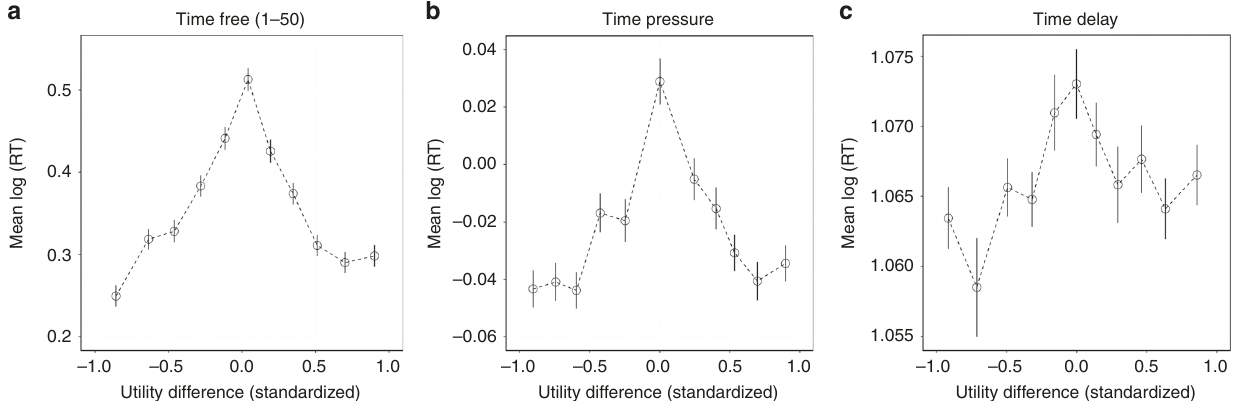
Fig. 3 The relationship between log(RT) and utility difference (between Option A and Option B in the experiment) in the three time conditions. a The time- free condition, b the time-pressure condition, and c the time-delay condition. We standardize the utility differences to [ − 1,1] at the individual level ( N S = 102) and divide all the data in each time condition into 11 bins with equal size. Each circle represents one bin. Error bars represent standard errors across subjects. We only used 50 time-free trials (Games 1 – 50) to make the analysis comparable to the time-pressure and time-delay conditions, but we fi nd similar results using all 100 time-free trials